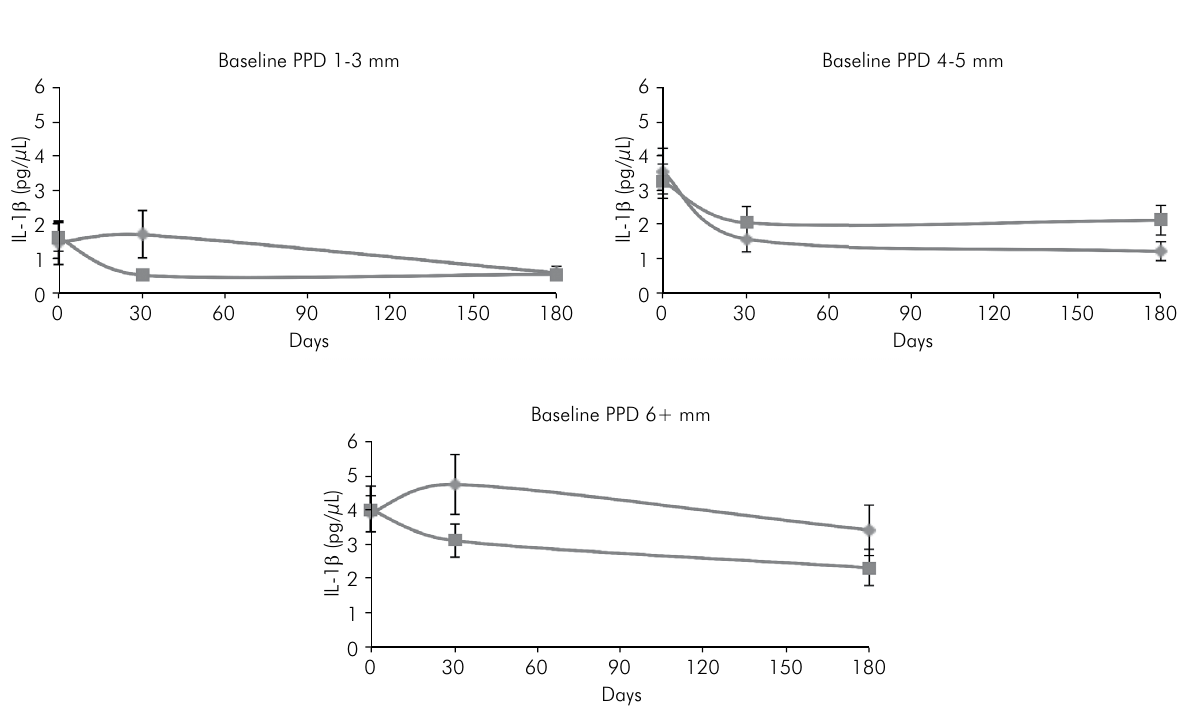
Figure 2. Means (with standard-error bars) of IL-1 β concentraton over the study period by smoking status and baseline PPD values. There were no significant differences between never-smokers and